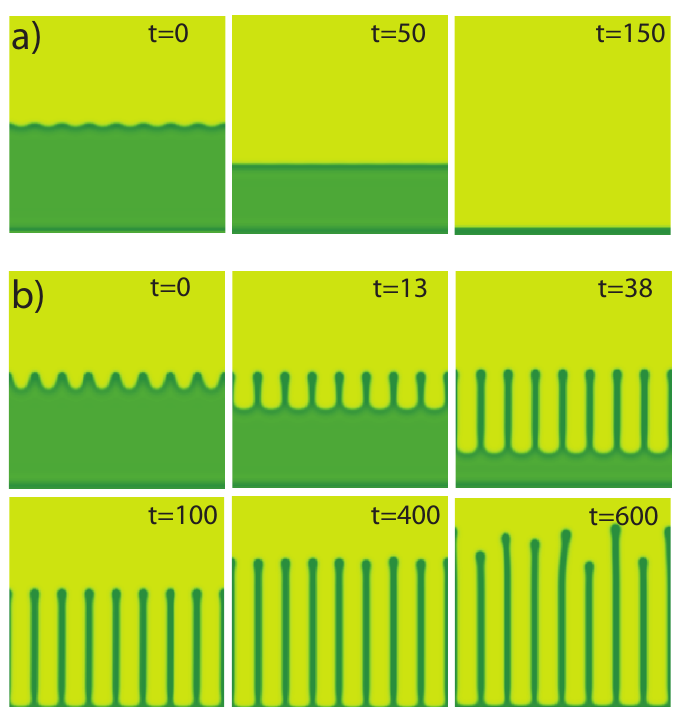
Figure 6. Nonlinear front instability in a tristability range. Snapshots of numerical model solutions showing ( a ) the stability of a planar desertification front to small transverse modulation, ( b ) instability to transverse modulations that are sufficiently large, and the development of vegetation fingers that grow back into bare soil. The time indicated in every snapshot is in units of years. From